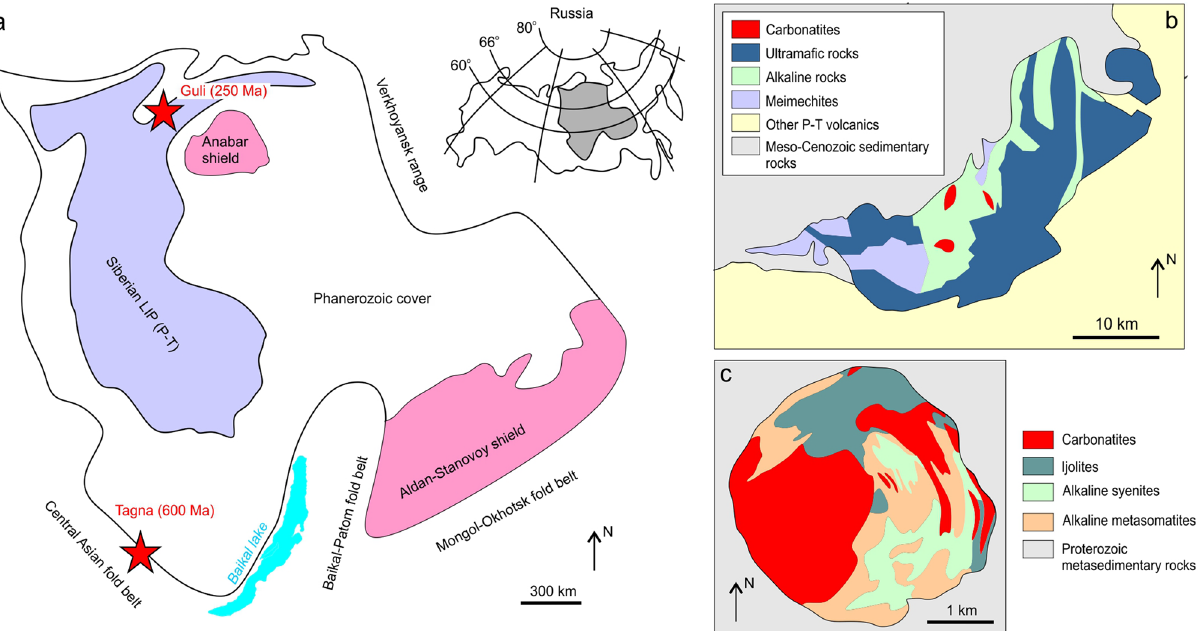
Figure 1. Geological layout of the studied massifs. ( a ) location of the Guli and Tagna massifs within the Siberian platform (modified after 33,34 ); ( b ) Geological scheme of the Guli massif (modified and simplified after 29 ); ( c ) Geological scheme of the Tagna massif (modified and simplified after 31,32 ). The figure was created using Corel Draw X4 software https:// www. corel draw. com/ en/ pages/ corel draw-